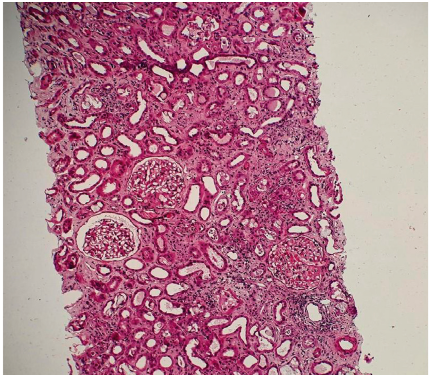
Figure 3: H&E (X200): diffuse acute tubular injury characterized by tubular epithelial simplification and dilation with numerous pale refractile intratubular